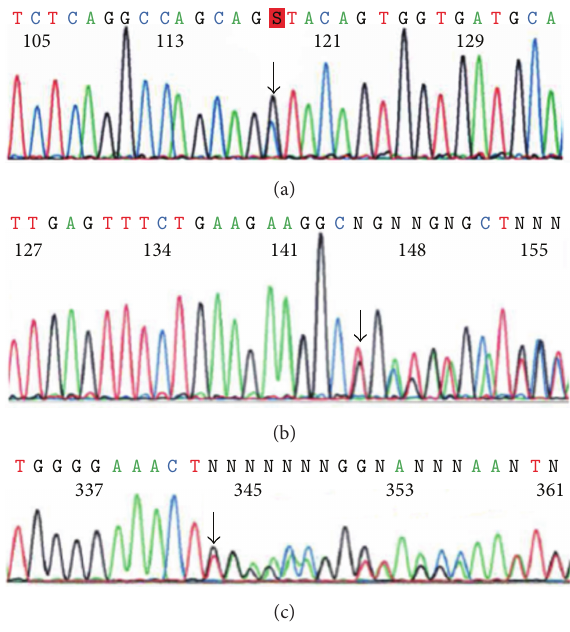
Figure 2: DNA sequencing results in three LS patients. (a) Patient LS-23 with c.2103+1G > C in the MLH1 gene. (b) Patient LS-41 with two different mutations in the MLH1 gene: c.1852 1854delAAG (p.K618del) and c.1852 1853delinsGC (p.K618A). (c) Patient LS-52 with mutation c.638dupT in the MSH2 gene. The arrows indicate the location of the